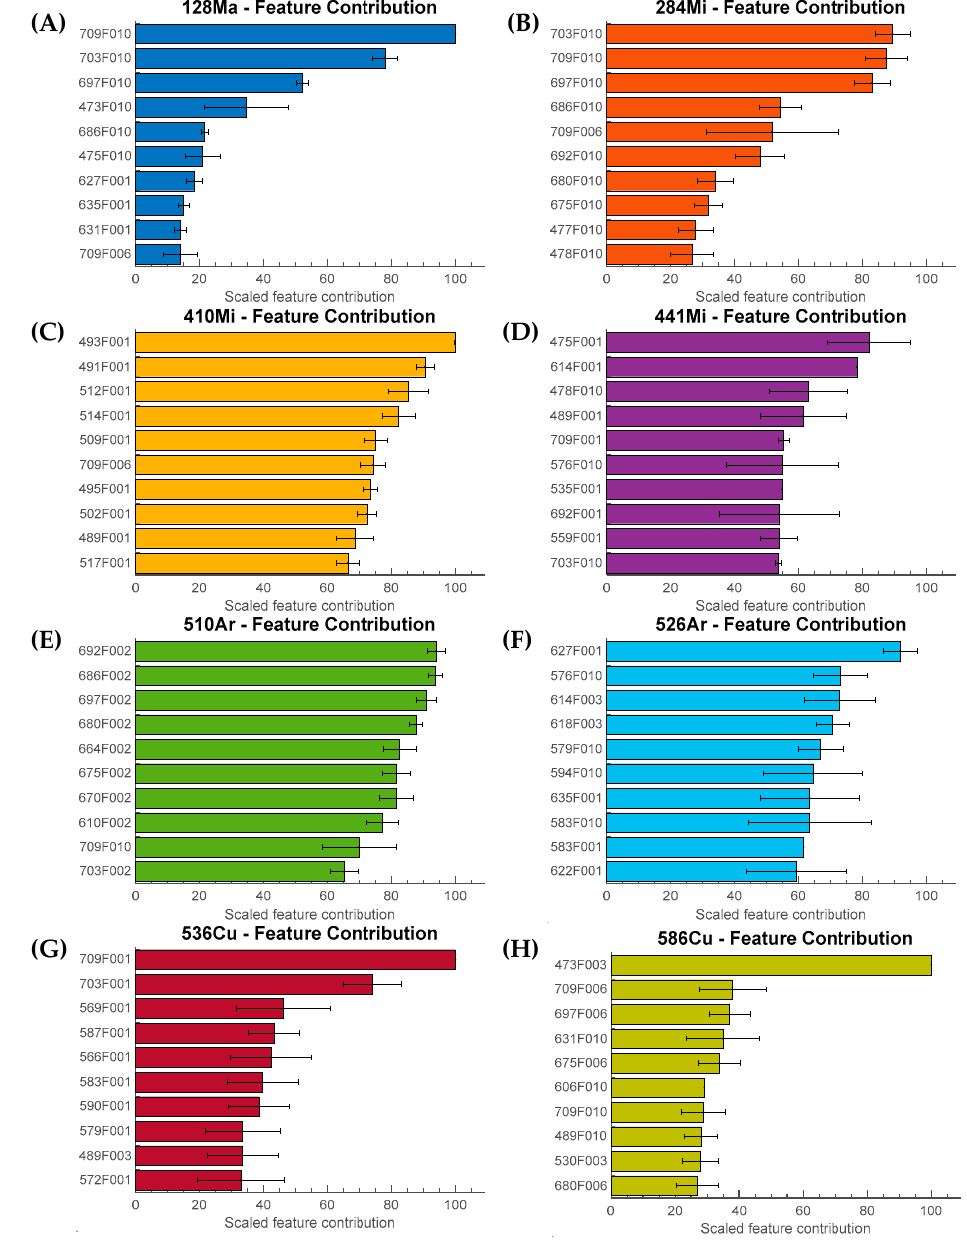
Figure 7. Top 10 contributing features and the normalized contribution values for individual organisms are presented: ( A ) 128- Massilia , ( B ) 284- Microbacterium , ( C ) 410- Microbacterium , ( D ) 441- Microbacterium , ( E ) 510- Arthrobacter , ( F ) 526- Arthrobacter , ( G ) 536- Curtobacterium , and ( H ) 586- Curtobacterium . The most contributing features for each organism are identified by LIME. The feature contribution was scaled based on the feature with the highest contribution value. The result is an average of 10 repetitions, and the error bar represents the standard deviation. The feature names are defined by their wavelength followed by “F” and the index position of the corresponding feature.